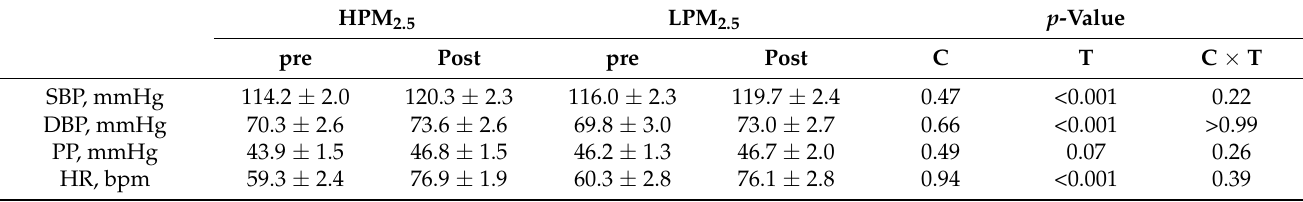
Table 2. Blood pressure and heart rate at pre- and post-exercise